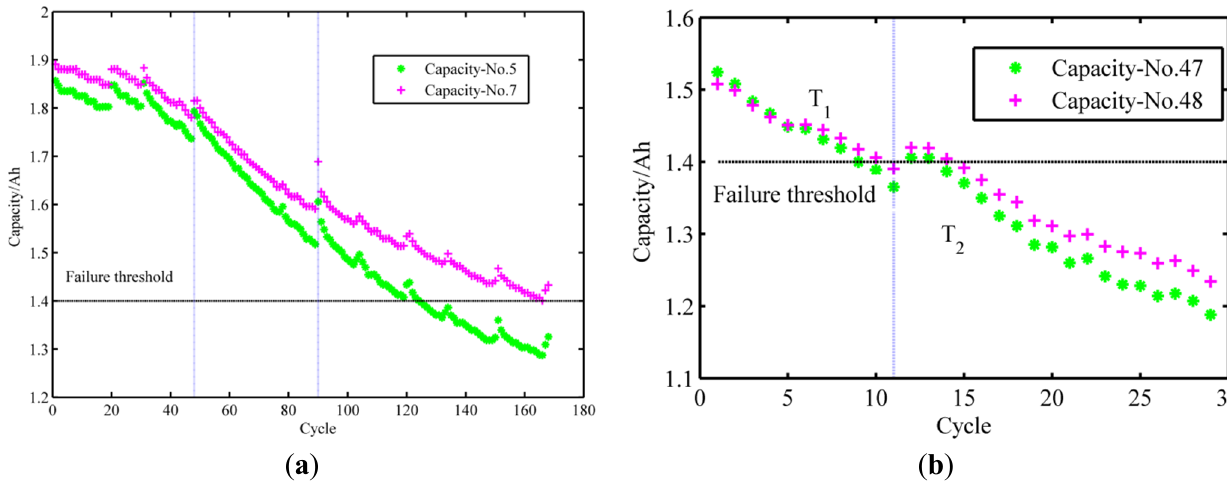
Figure 4. Regions of the capacity at different ambient temperature of ( a ) 24 °C and ( b ) 4